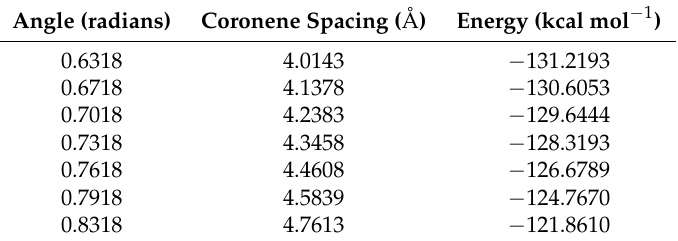
Table 5. Minimum energy intermolecular spacings corresponding to given angles for stack of three coronene encapsulated within ( 18,0 )